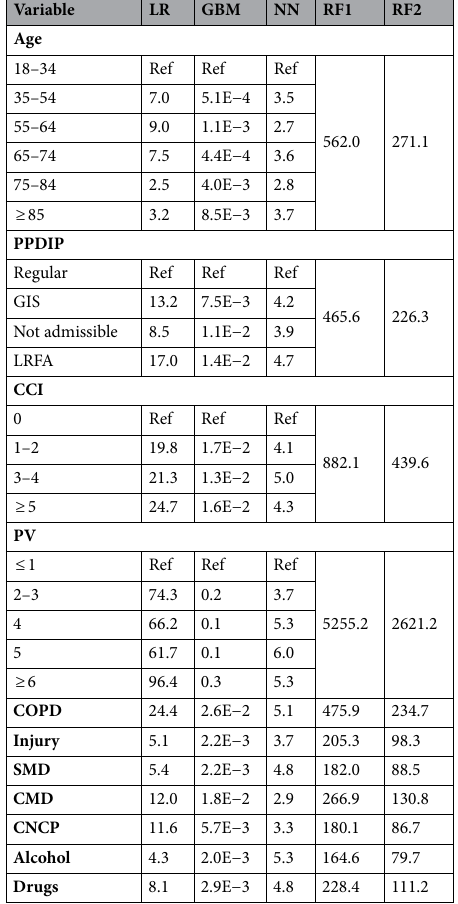
Table 5. Variable importance for the predictive models (frequent users 3). The higher the value, the higher the importance (relative to a model). LR logistic regression, GBM gradient boosting machine, NN neural network, RF random forests (1: binary outcome, 2: continuous